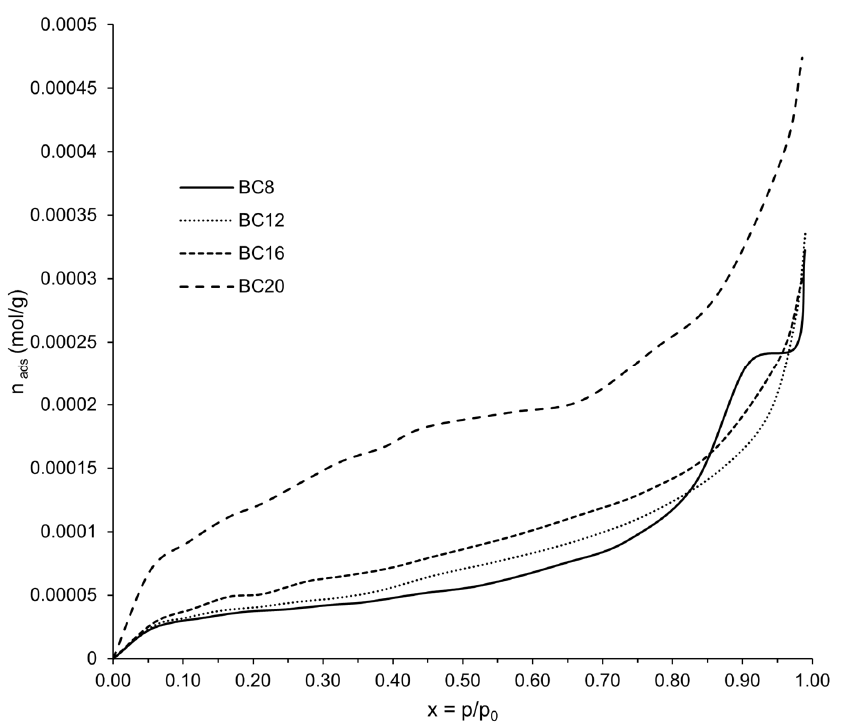
Figure 4. Nitrogen adsorption of wild sugarcane biochar (WSB) produced at different airflow rates. BC stands for biochar, and the number represents the airflow rate used for gasification, e.g., BC8—8 L/min. Table 2 summarizes the results of proximate analysis on wild sugarcane biochar.